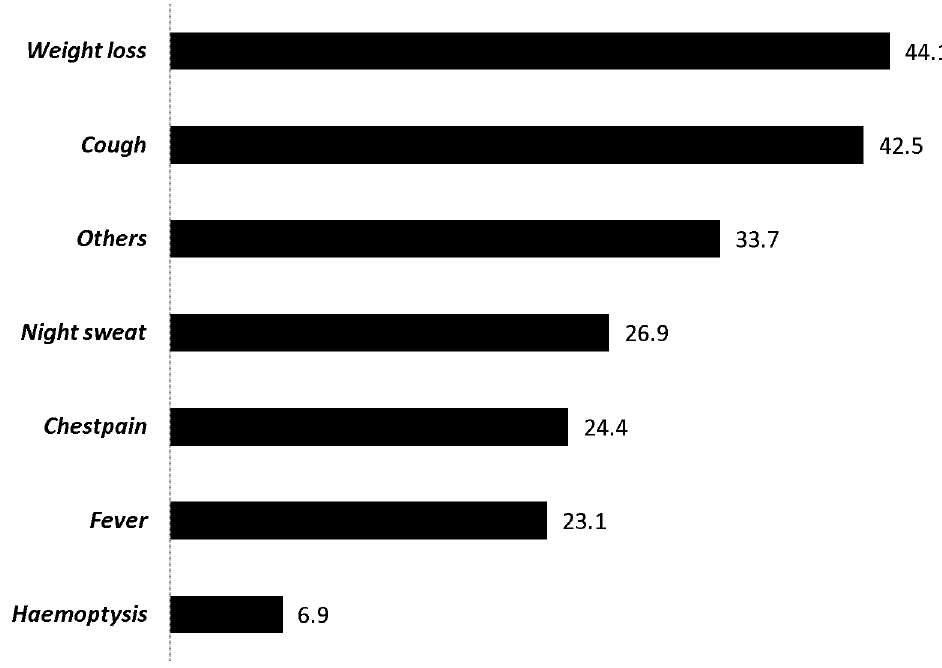
Figure 3. Mean duration of symptoms in days among PTB patients, Southern Ethiopia, June-December 2012.